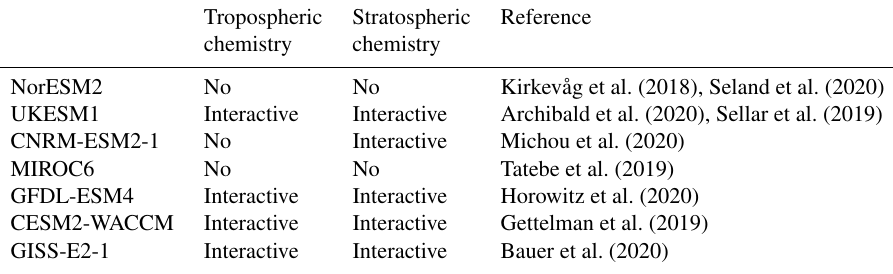
Table 2. Sophistication of gas-phase chemistry used in the Earth system models (for further details, see Thornhill et al., 2020).